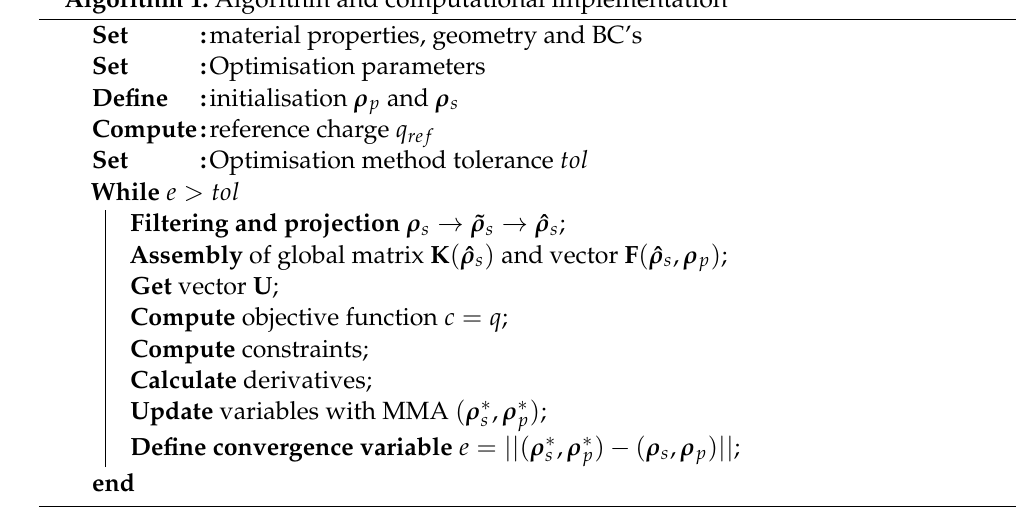
Algorithm 1: Algorithm and computational implementation